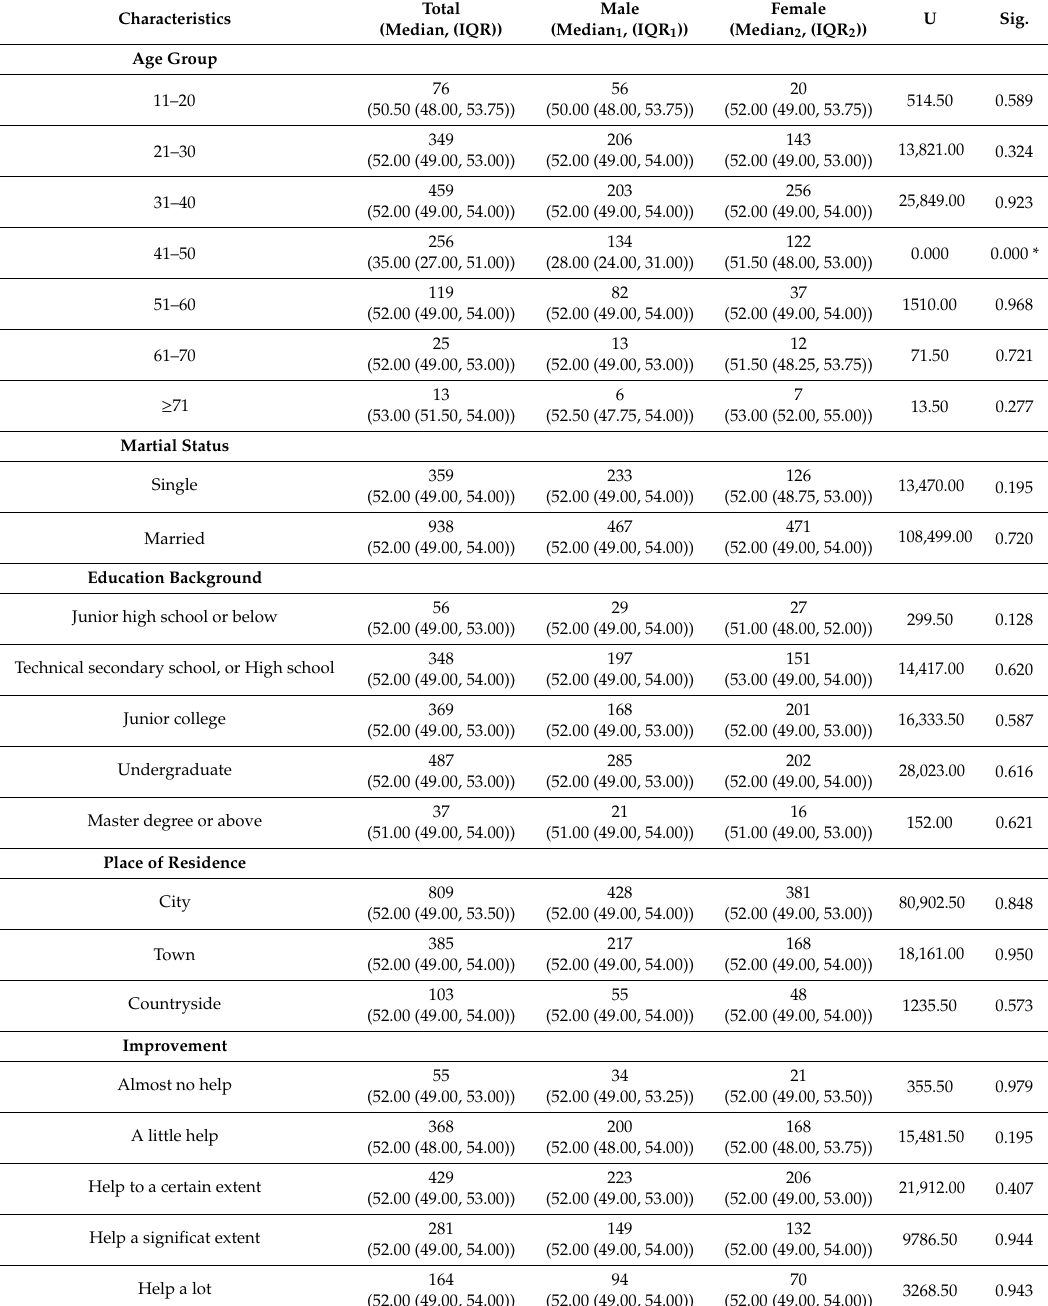
Table 2. The distribution of basic information and social support scores in every case between male and